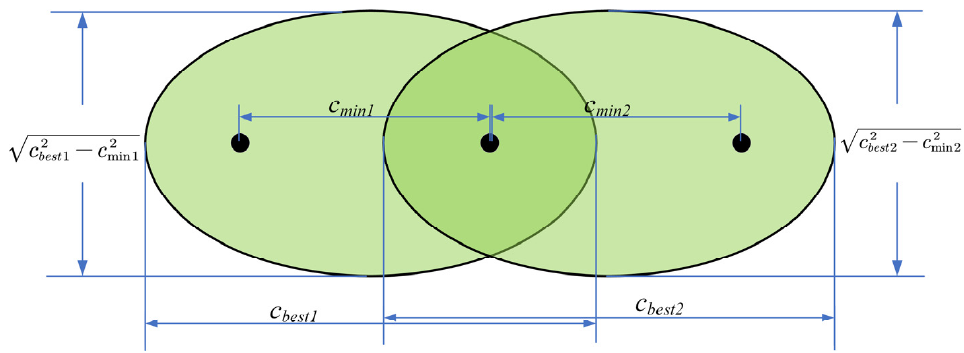
Figure 5. Double elliptic domain.